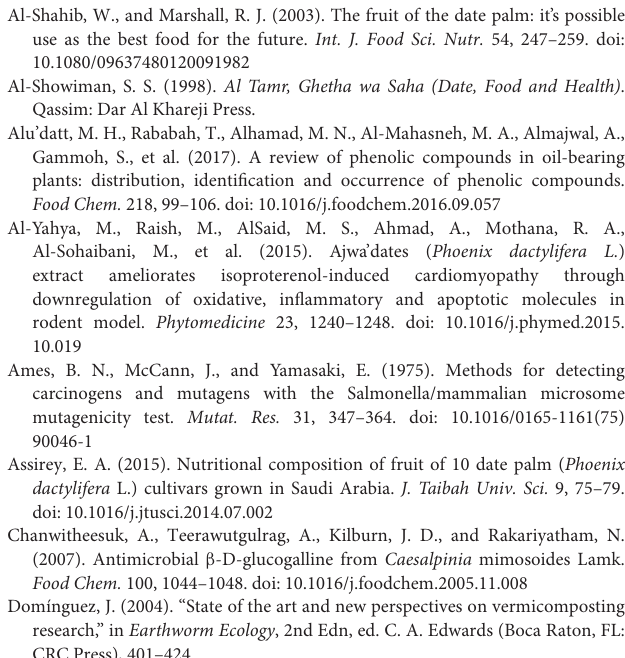
were harvested at the tamar stage. Different letters represent significant differences between the treatments in the cultivar (Duncan test; P < 0.05 and n = 4). TABLE S7 | Phenolics and flavonoid compound concentrations in vermicompost-fertilized and non-fertilized P. dactylifera cv. Ajwa, Hulwa, Ruthana, Sefri, and Luban fruits. Vermicompost fertilization was carried out at a rate of 10 Kg/tree and fruits were harvested at the tamar stage. Different letters represent significant differences between the treatments in the cultivar (Duncan test; P < 0.05 and n = 4). TABLE S8 | Medicinal bioactivities of the ethanol extracts of vermicompost-fertilized and non-fertilized P. dactylifera cv. Ajwa, Hulwa, Ruthana, Sefri, and Luban fruits. Vermicompost fertilization was carried out at a rate of 10 Kg/tree and fruits were harvested at the tamar stage. Different letters represent significant differences between the treatments in the cultivar (Duncan test; P < 0.05 and n = 4). TABLE S9 | Antimicrobial activity of β - D -glucogallin (100 µ g/disc) extracted from Ajwa date fruits. Values are expressed as average of three replicates ± SD. Different letters represent significant differences between the treatments in the same raw (Duncan test; P < 0.05 and n = 4). TABLE S10 | Antimutagenic potential of β - D -glucogallin against S. typhimurium TA98 and TA100 bacterial strains. Values are expressed as the average of three replicates ± SD. Different letters represent significant differences between the treatments in the same raw (Duncan test; P < 0.05 and n = 4). TABLE S11 | Antiprotozoal activity of the investigated β - D -glucogallin against Trypanosoma cruzi and Leishmania donovani . Activities are presented as IC 50 µ g/mL (Standard compounds: Benznidazole a and Miltefosine b ). Values are expressed as the average of three replicates ± SD. Different letters represent significant differences between the treatments in the same raw (Duncan test; P < 0.05 and n = 4). TABLE S12 | Antioxidant capacity using DPPH and FRAP assays of the isolated β - D -glucogallin. DPPH: 2,2-diphenyl-1-picrylhydrazyl, FRAP: ferric reducing antioxidant power. Values are expressed as the mean of three replicates ± SD. Different letters represent significant differences between the treatments in the same raw (Duncan test; P < 0.05 and n =